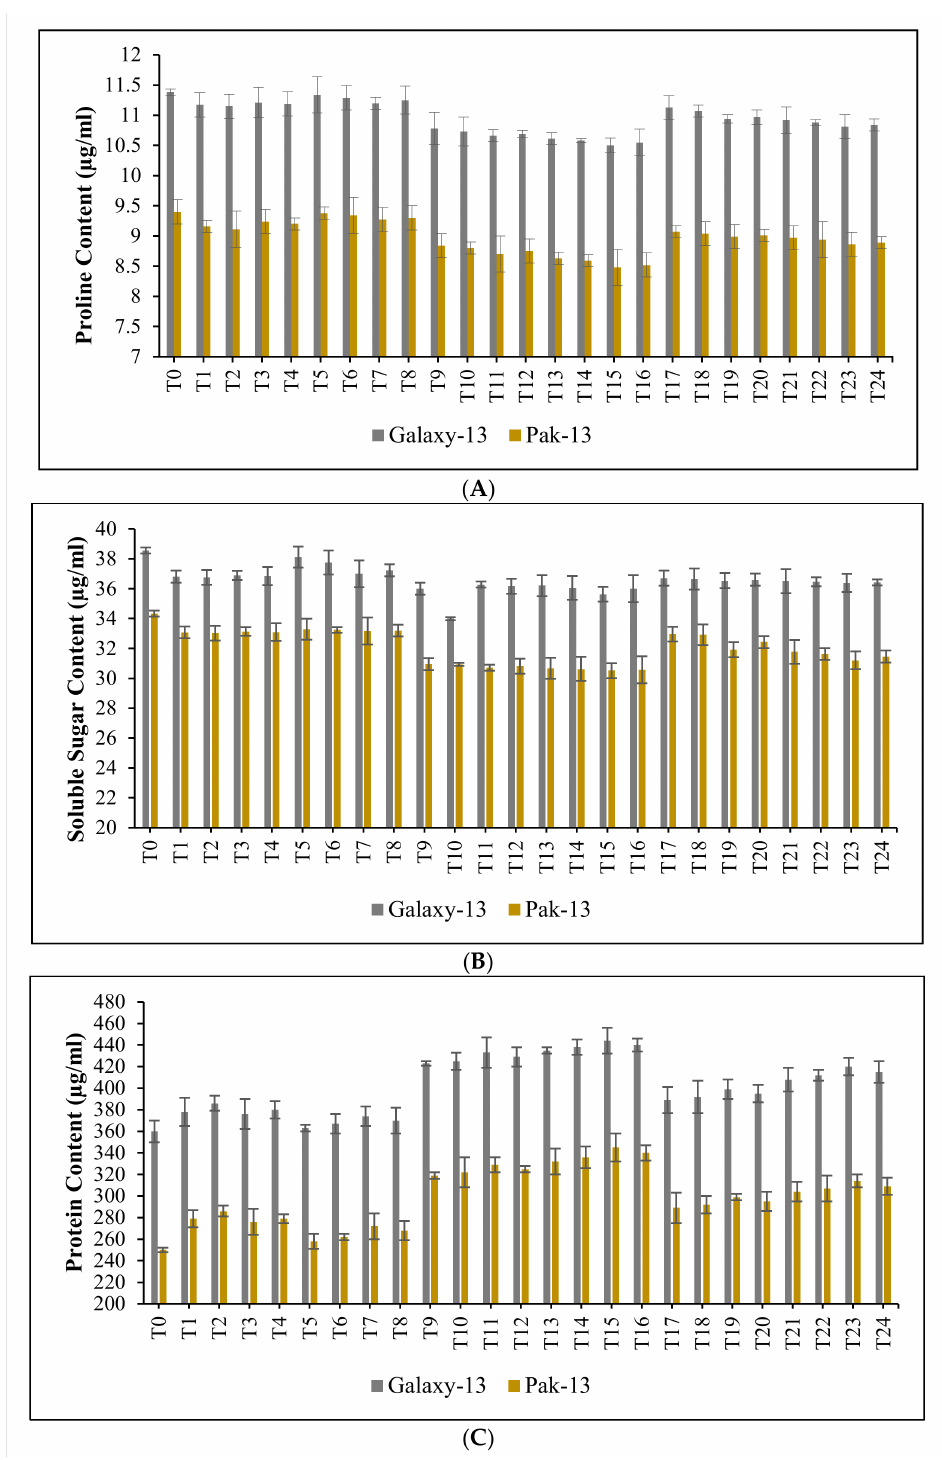
Figure 4. ( A ): effect of phytogenically synthesized bimetallic Ag/ZnO nanomaterials and nitrogen- based fertilizers on proline content of wheat varieties; ( B ): effect of phytogenically synthesized bimetallic Ag/ZnO nanomaterials and nitrogen-based fertilizers on the soluble sugar content of wheat varieties; ( C ): effect of phytogenically synthesized bimetallic Ag/ZnO nanomaterials and nitrogen-based fertilizers on the protein content of wheat